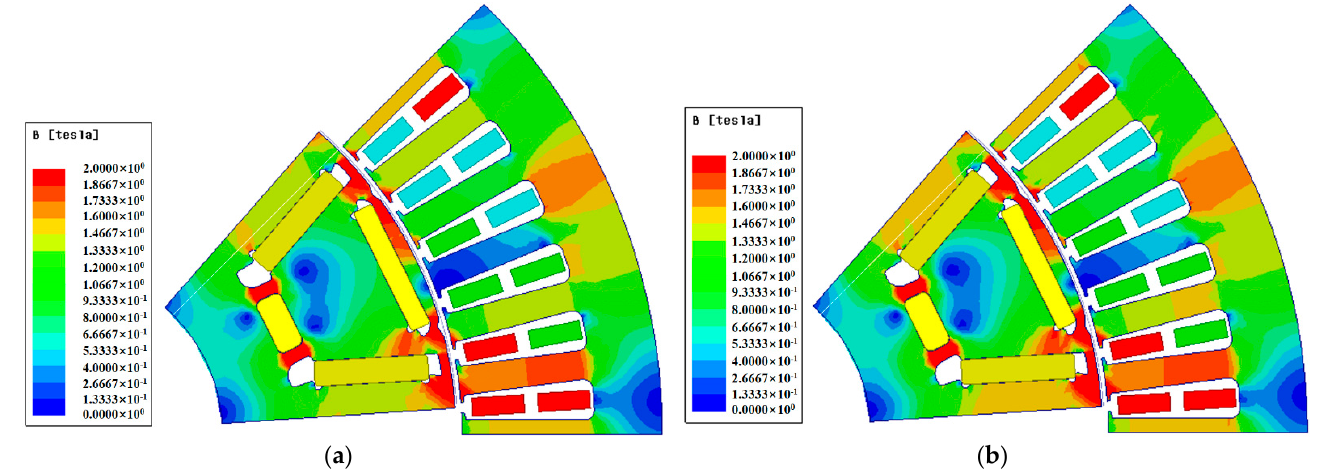
Figure 9. Flux density distribution of two materials motor under loaded condition. ( a ) 10JNEX900.